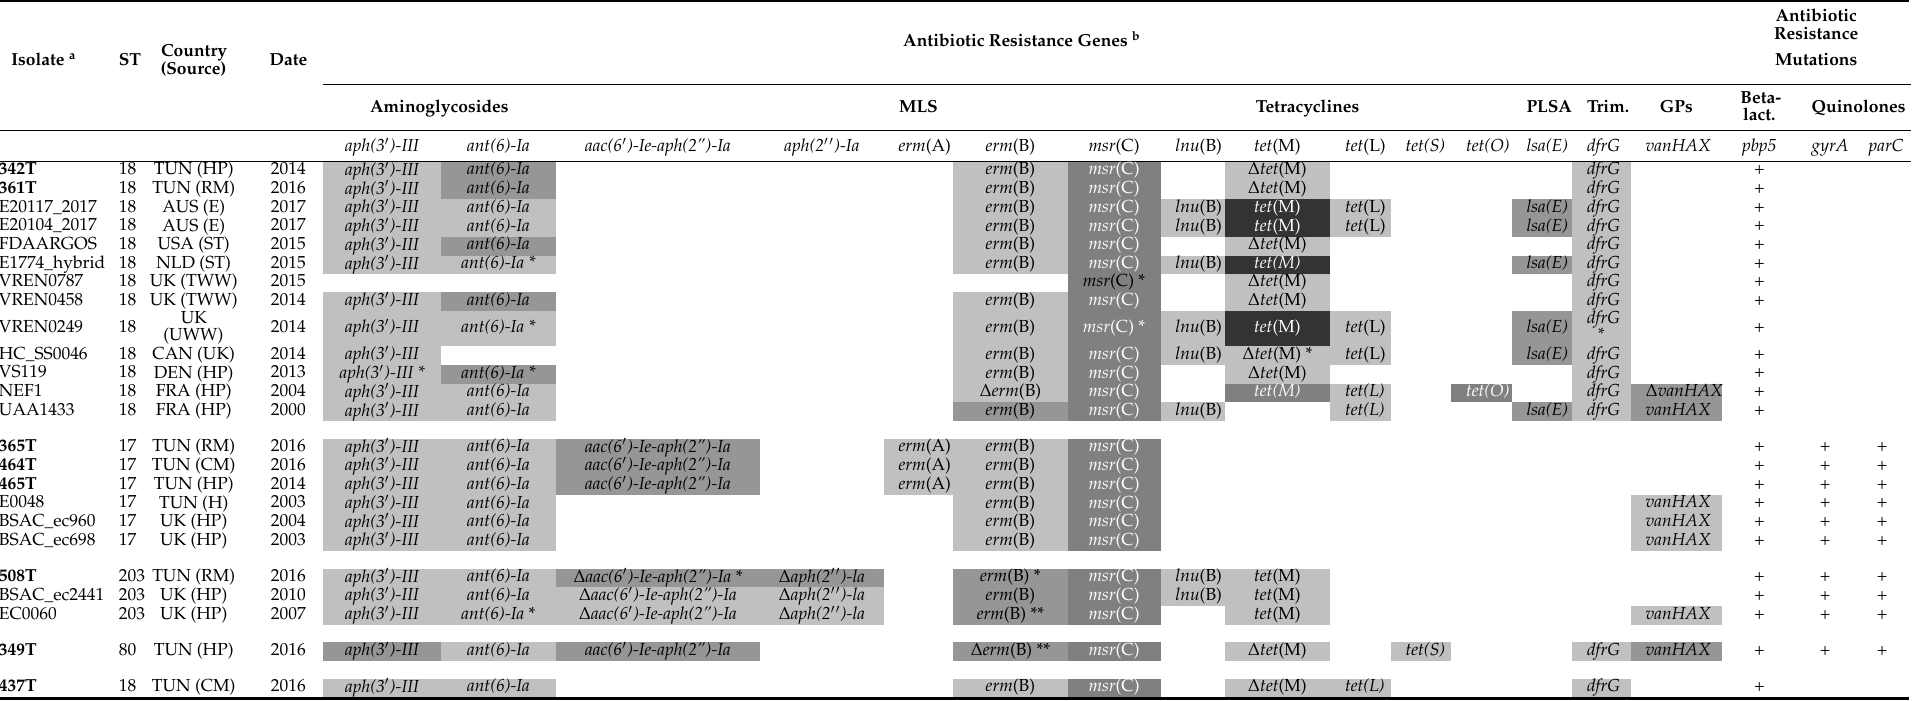
Table 1. Epidemiological data and antibiotic resistance genomic content (acquired genes and chromosomal mutations) in the 24 analysed strains.